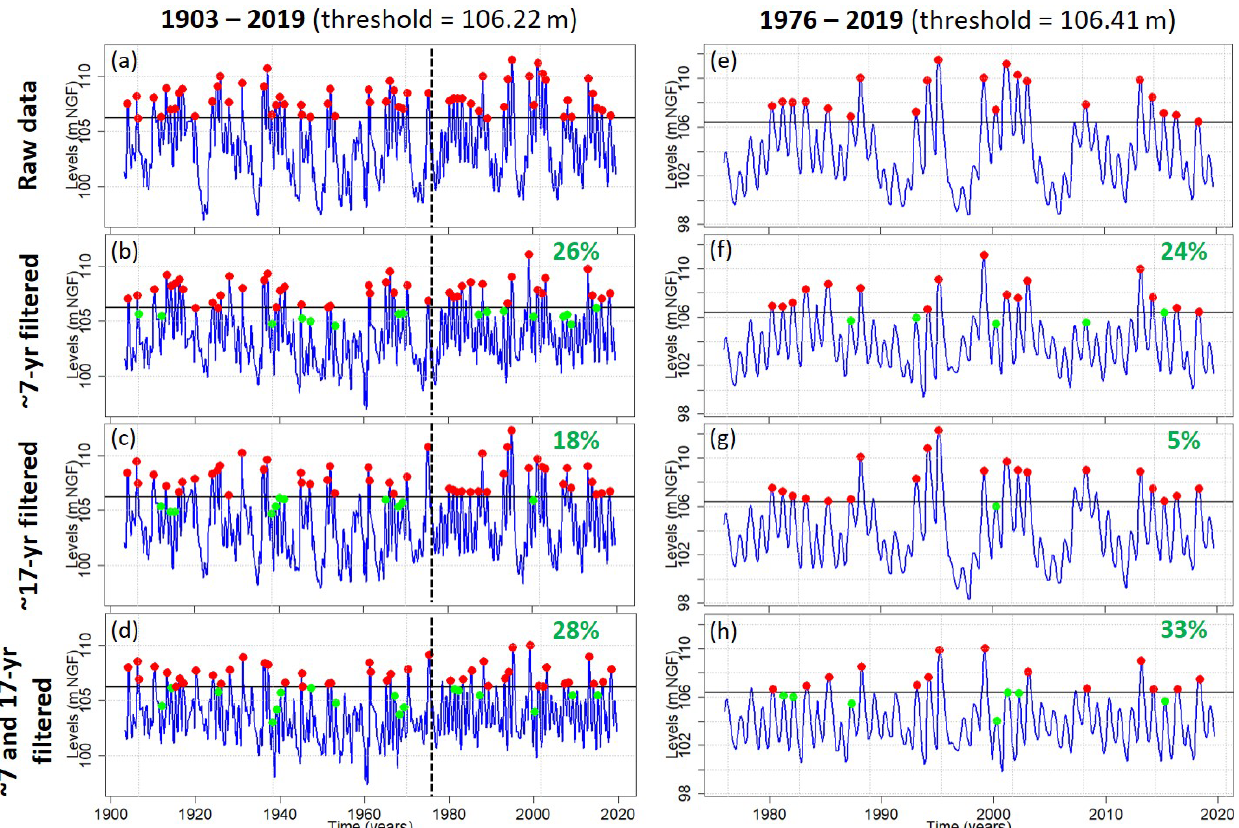
Figure 9. Influence of ∼ 7-year (MAV), ∼ 17-year (DV), and ∼ 7- and ∼ 17-year variabilities on the occurrence of HLs for the Tincques’ GWL over the 1903–2019 and 1976–2019 periods. The percentage of HLs generated by the filtered component(s) (i.e., moving below the percentile 0.8) is indicated in green. The dotted black line represents the year